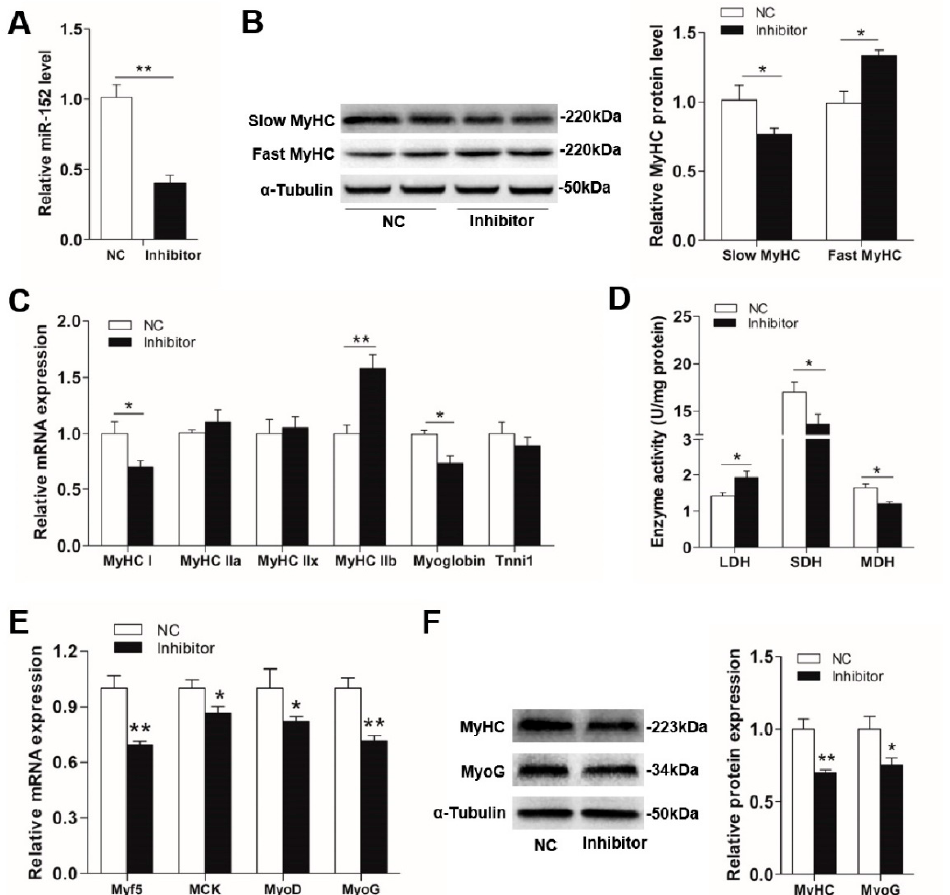
Figure 3. The e ff ects of miR-152 inhibitor transfection on myofiber specification and skeletal myogenesis in porcine myotubes. ( A ) The miR-152 level was examined by RT-PCR at four days post transfection. ( B ) The protein expression of MyHC isoforms in porcine myotubes was detected at four days after transfection with the miR-152 inhibitor. α -Tubulin served as an internal control. ( C ) MyHC isoforms and oxidative fiber markers in porcine myotubes transfected with the miR-152 inhibitor were determined by RT-PCR. ( D ) Metabolic-related enzymes activities in porcine myotubes transfected with the miR-152 inhibitor. ( E ) Relative mRNA levels of Myf5 , MCK , MyoD , and MyoG were detected by RT-qPCR at four days after miR-152 inhibitor transfection. ( F ) The protein expression of myogenic markers, MyHC and MyoG, were detected by western blot at four days after miR-152 inhibitor transfection and analyzed using image J. Results are exhibited as mean ± S.E.M. ( n = 4, four independent experiments). * p < 0.05, ** p < 0.01 and *** p < 0.001 when contrasted with the control.